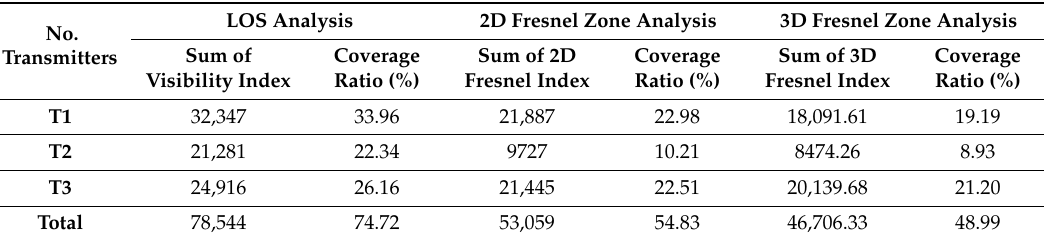
Figure 7. Index maps generated by LOS analysis, 2D Fresnel zone analysis, and 3D Fresnel zone analysis for transmitter 1, transmitter 2, and transmitter 3 in the study area. Table 1. Variation of index values and the coverage ratio derived from each method for different transmitter location thresholds.